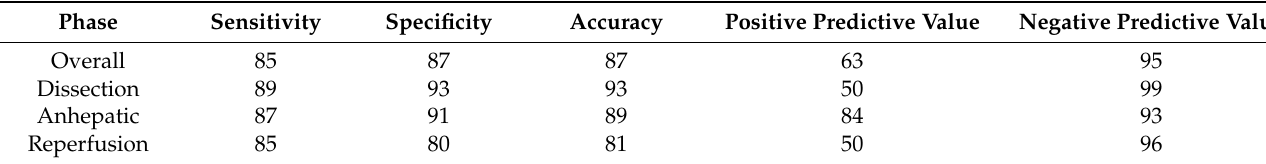
Table 3. Evaluation of diagnostic power of